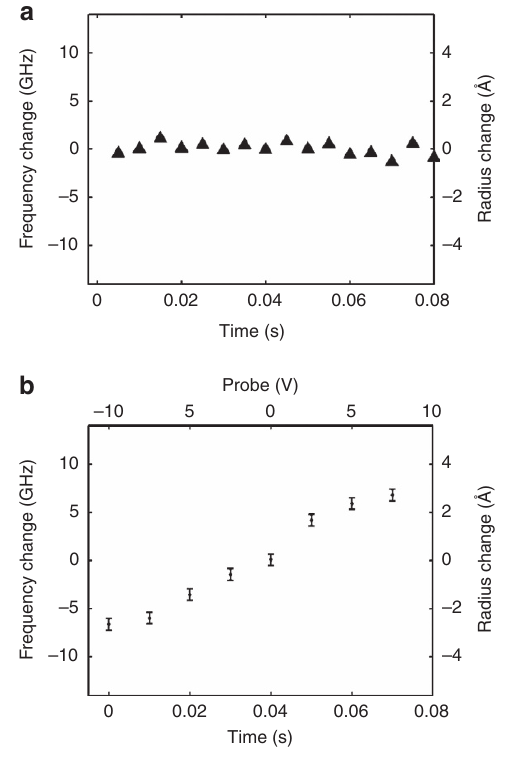
Figure 3 | Experimental results. ( a ) Monitoring the droplet size through its resonance frequency reveals a s.d. of 0.3Å in radius during a 0.08s period. Parameters here are similar with the ones in Fig. 2c where the resonance frequency is revealed from the centre of the best-fitting Lorentzian (red line, Fig. 2c). ( b ) Controlling the water-droplet size and its resonance frequency by applying an external voltage. Parameters are similar to ( a ) except for an electrode here that was located 300 m m from the droplet. The error bars in ( b ) represents the s.d. when voltage was not applied ( a ). We note that the water reservoir is always